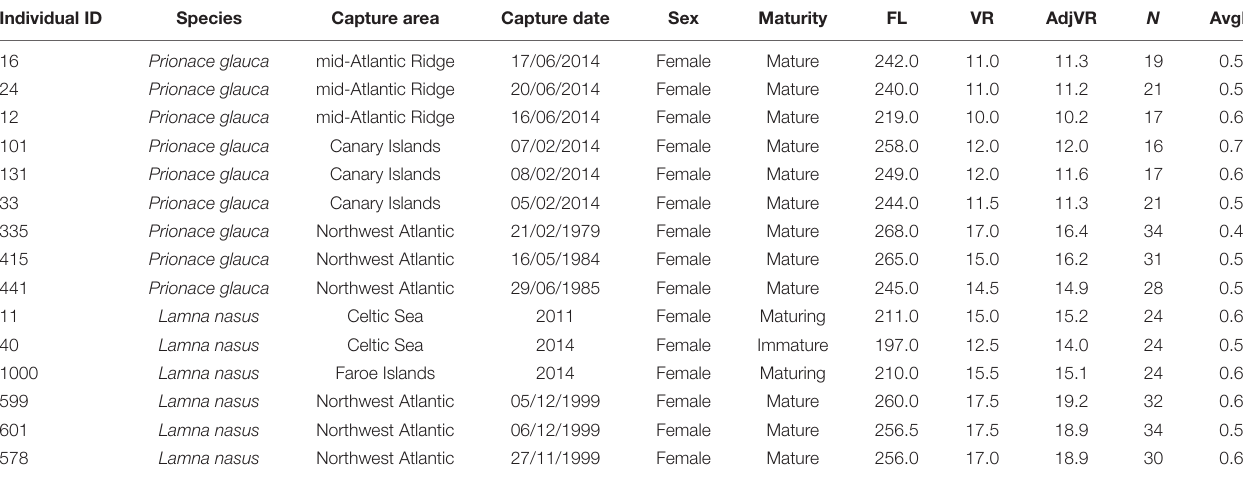
TABLE 1 | Metadata for individual blue sharks ( Prionace glauca ) and porbeagles ( Lamna nasus ) analyzed for stable isotopes, including individual ID, species, capture area, capture date or year, sex, maturity stage, fork length (FL, cm), vertebral radius (measured: VR, mm; adjusted VR: AdjVR, mm), number of samples collected for each vertebra (N), and (achieved) average interval between adjacent samples (AvgInt,